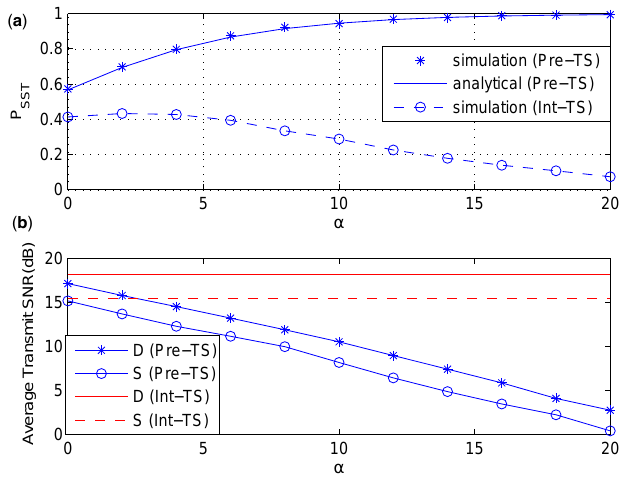
Figure 9. ( a ) P SST under various α . ( b ) The average transmit SNR under various α